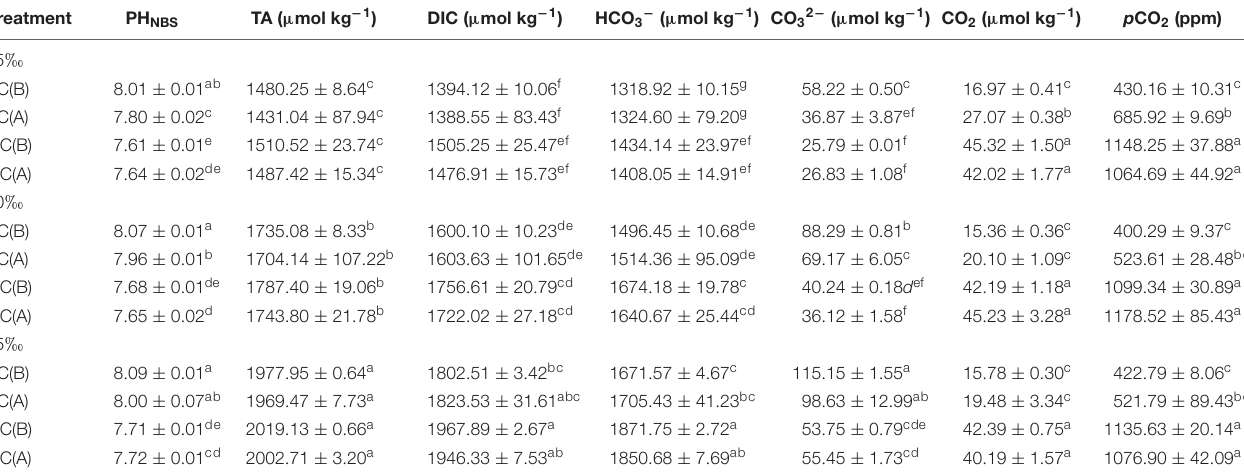
TABLE 1 | Carbonate chemistry parameters in the cultures of E. huxleyi before (B) inoculation (already equilibrated with the ambient or elevated CO 2 levels) and after (A) about 8 generations prior to determination of physiological parameters.